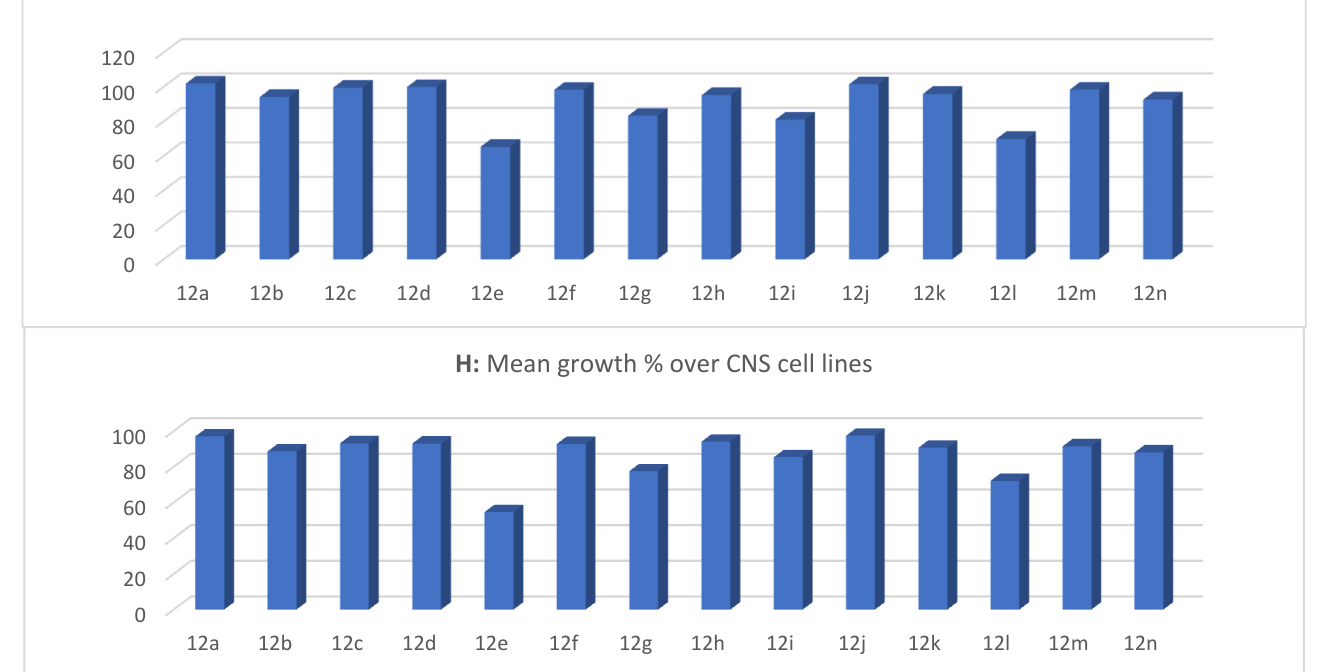
G: Mean growth % over colon cancer cell lines